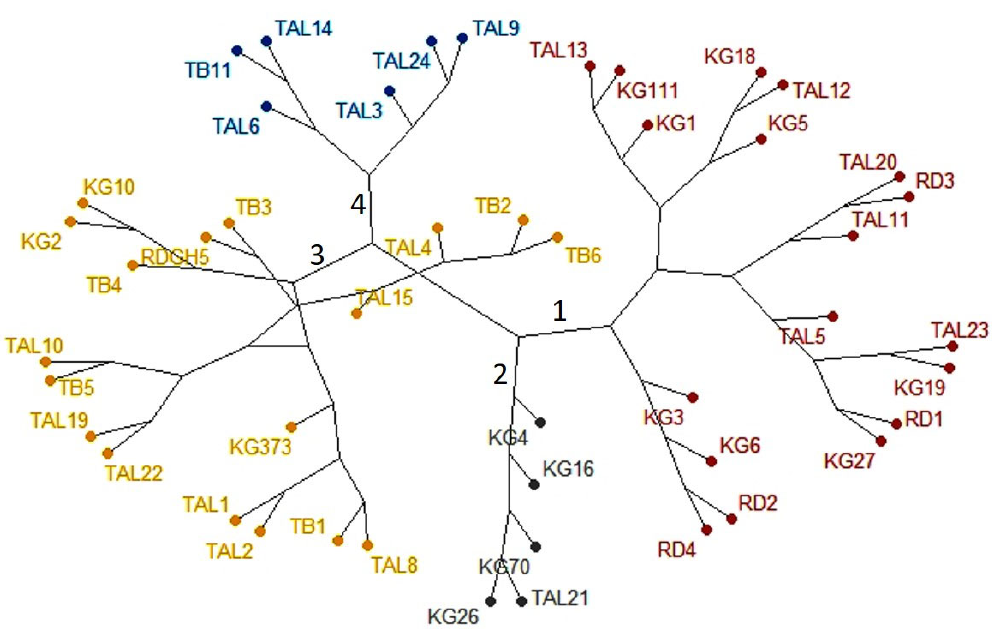
Figure 6. Estimated value of k ‐ means for structure analysis and identification of optimal numbers of clusters.